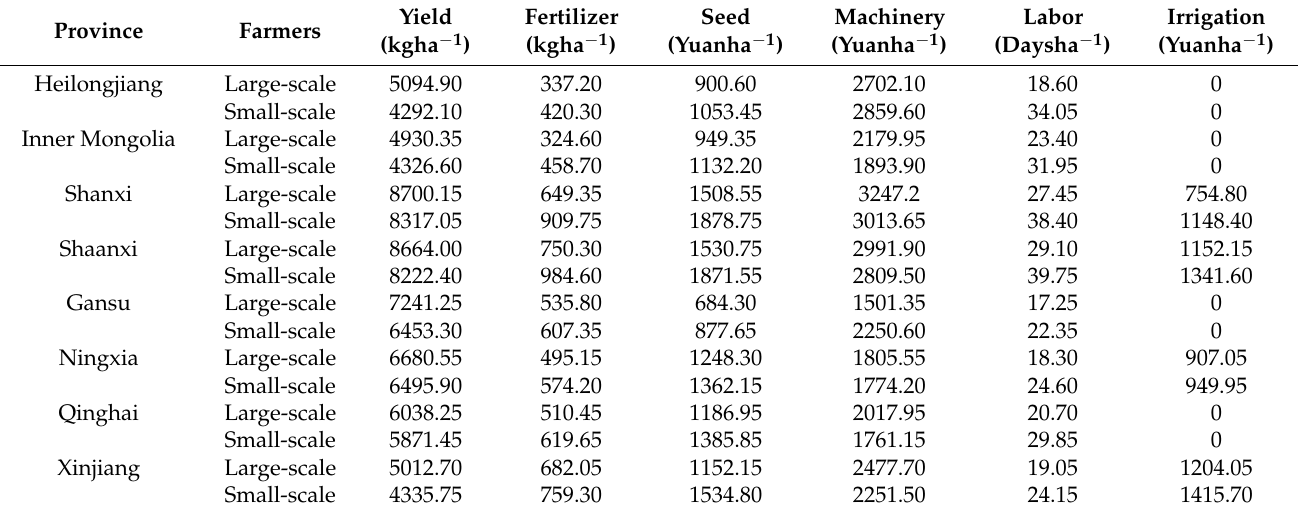
Table 3. Comparison of the input of production factors between small-scale and large-scale households in different